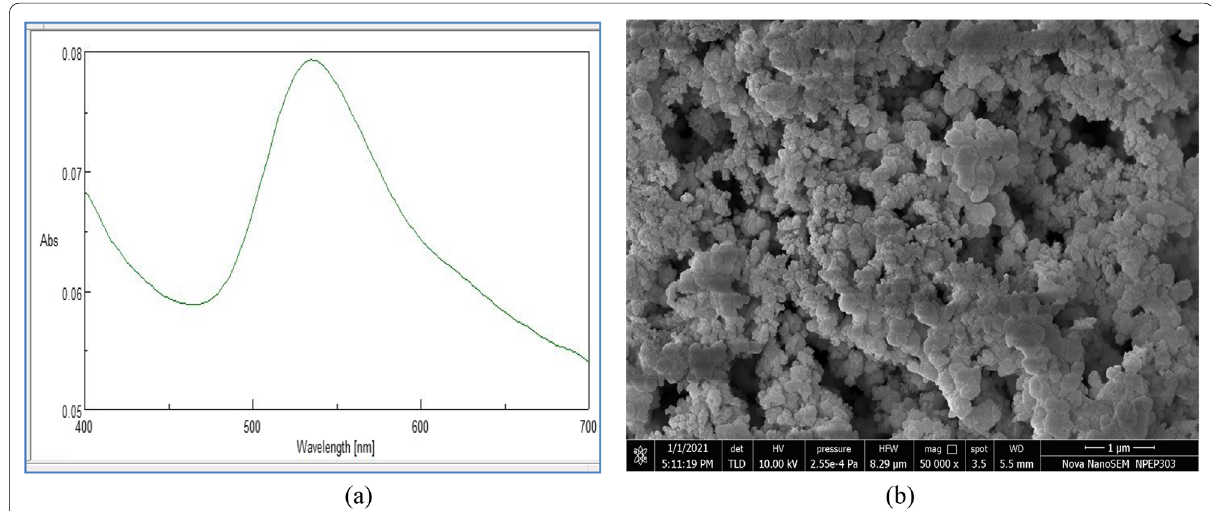
Fig. 1 a Absorption peak of CuNPs, showed peak at 530 nm, b scanning electron microscopy images of CuNPs showed the topography of